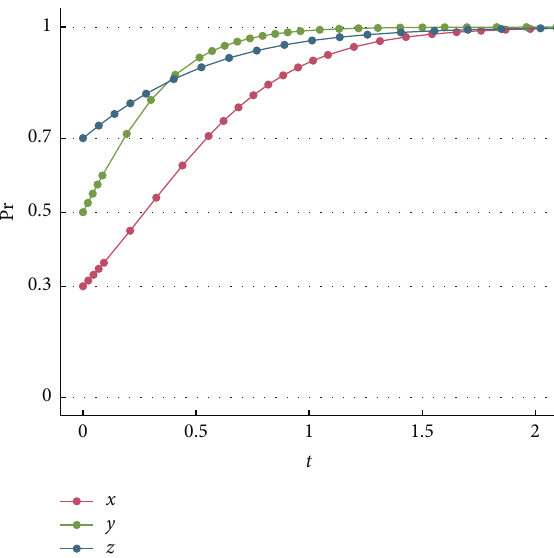
Figure 8: The final evolution result of E punishment